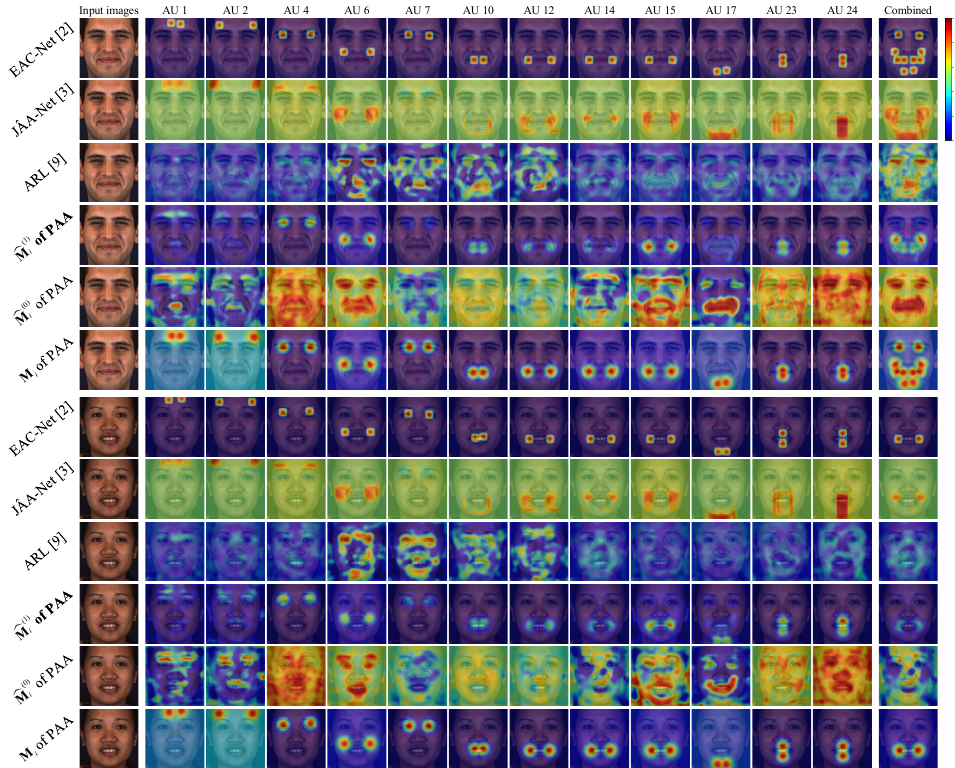
Figure 4. Visualization of learned attention maps of different methods, in which AUs 6, 7, 10, 12, 14, and 17 appear in the first image, and AU 14 appears in the second image. Each row lists the attention maps of 12 AUs, as well as the combined attention map of occurred AUs, for the corresponding method. Attention weights from zero to one are visualized using colors from blue to red, and are overlaid on the input images for a better